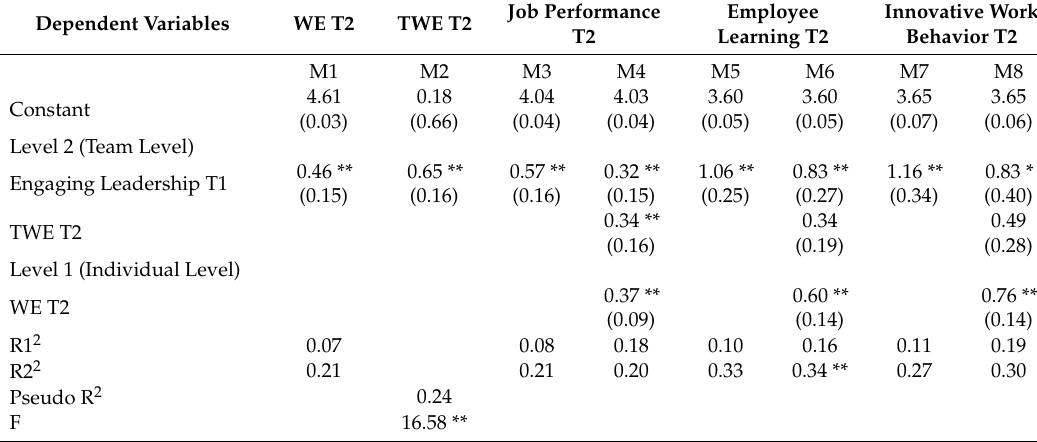
multi-level modeling coe ffi cients ( γ ) are shown. Robust standard errors are in parentheses. R1 2 = individual level variance component, and R2 2 = team-level variance component, Pseudo R 2 = proportion of variance explained